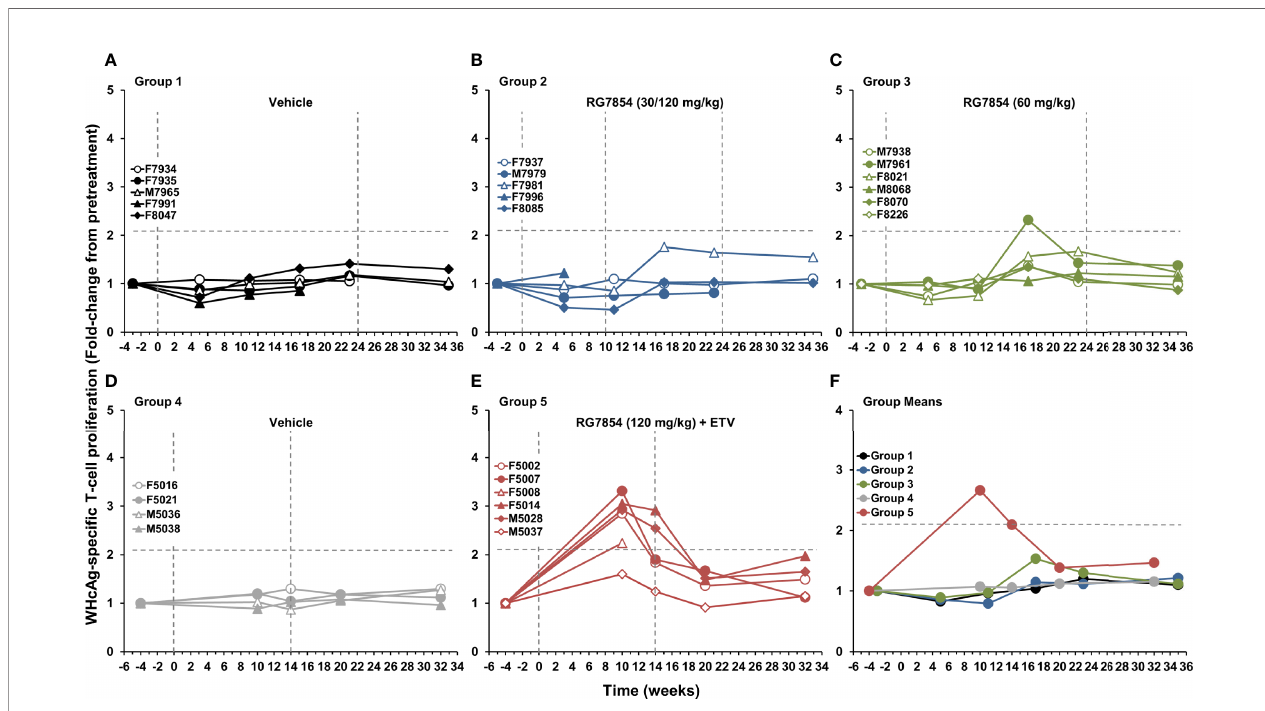
FIGURE 7 | Effect of RG7854, alone and together with ETV, on peripheral WHcAg-speci fi c T-cell response. Kinetics of PBMC proliferation to stimulation with WHcAg-derived peptides of individual woodchucks administered (A) placebo or RG7854 at doses of (B) 30/120 mg/kg or (C) 60 mg/kg in the monotreatment study and (D) placebo or (E) RG7854 at a dose of 120 mg/kg plus ETV in the combination treatment study. (F) Group mean WHcAg-speci fi c T-cell responses. The horizontal dotted lines indicate the cutoff for positive PBMC proliferation (i.e., ≥ 2.1-fold-change from the pretreatment baseline). The mean WHcAg-speci fi c T-cell response in Groups 2 and 3 was not signi fi cantly different to Group 1 ( P > 0.05) (Student ’ s t -test). The mean WHcAg-speci fi c T-cell response in Group 5 was signi fi cantly increased compared to Group 4 at weeks 10 and 14 ( P <